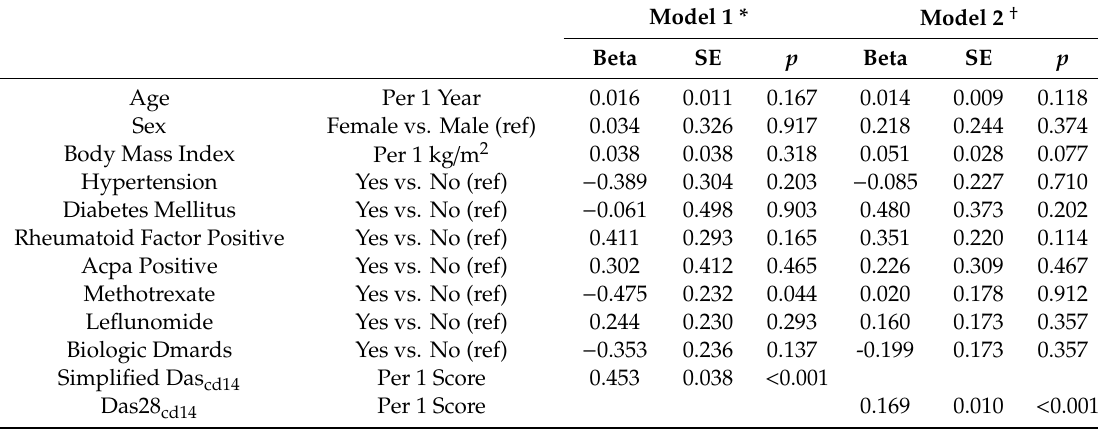
Table A2. Analysis of covariance (ANCOVA) of DAS28 ESR , adjustment for various covariates, including newly developed CD14-based RA disease activity indices.